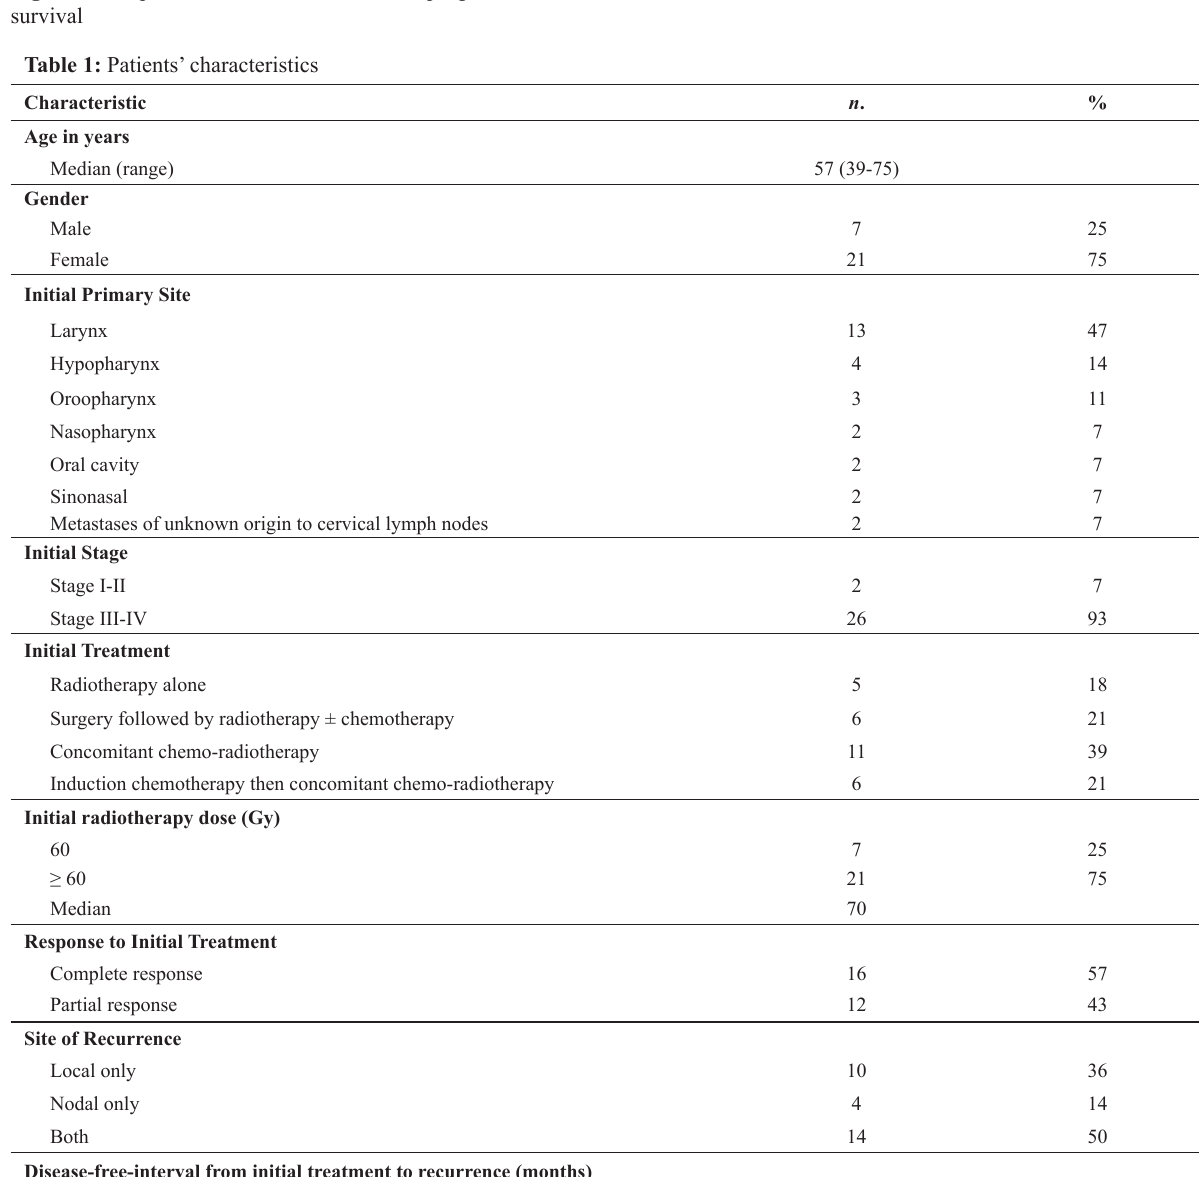
Figure 2: Kaplan–Meier survival curve of overall survival